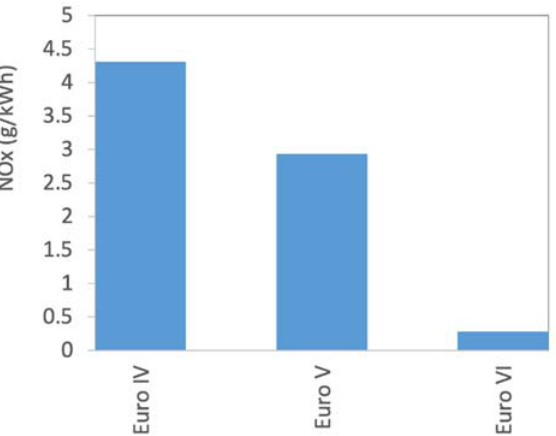
Figure 6. Evolution of NOx emission factors from Diesel heavy ‐ duty vehicles.